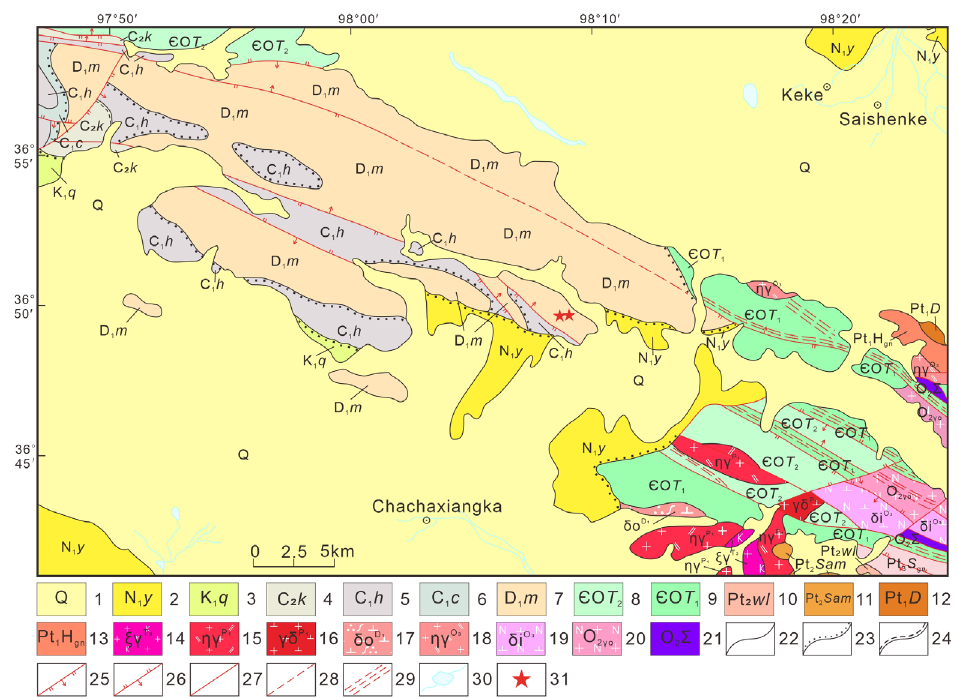
Figure 3. Simplified geological map of the Nankeke area, Wulan County, eastern segment of the